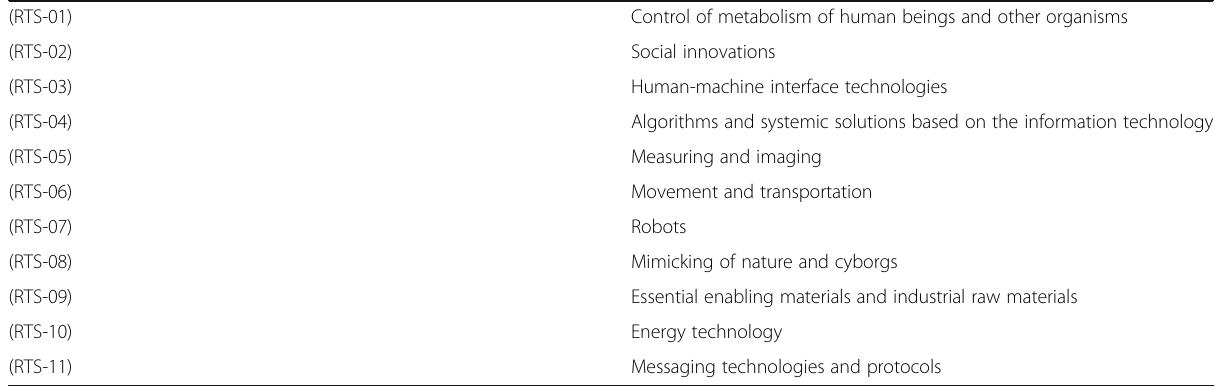
Table 1 Classes of Radical Technological Solutions according to the RTI